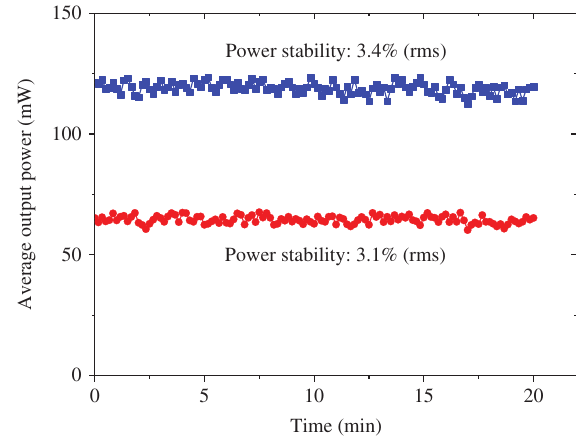
Figure 5: The average output power dependence on absorbed power in CW and QS modes; insets: the corresponding laser wavelengths and the laser beam spots at maximum output powers.